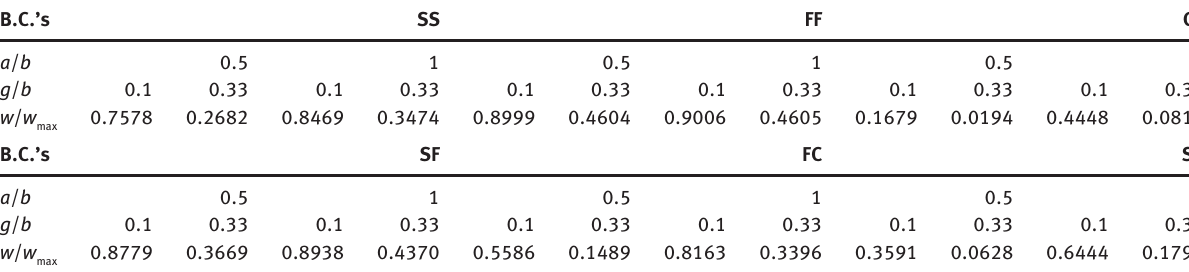
Table 1: Non-dimensional deflection for an isotropic micro-plate ( n = 0). B.C.’s